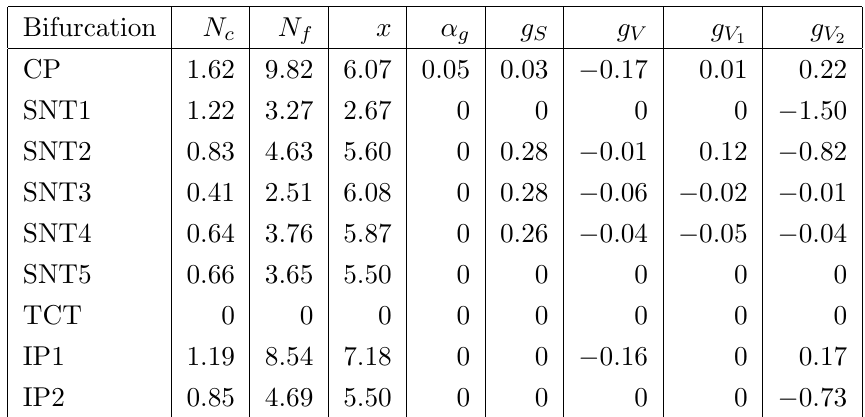
Table 4. Locations of bifurcations found in the model of QCD